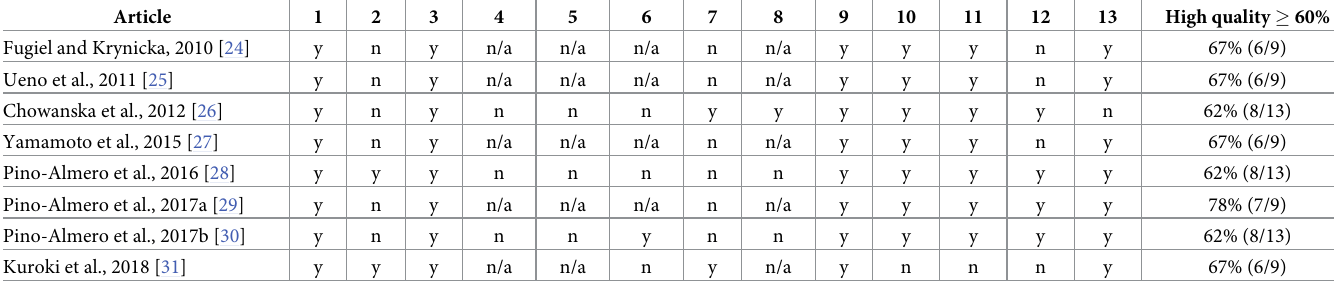
Table 2. Methodological quality of included